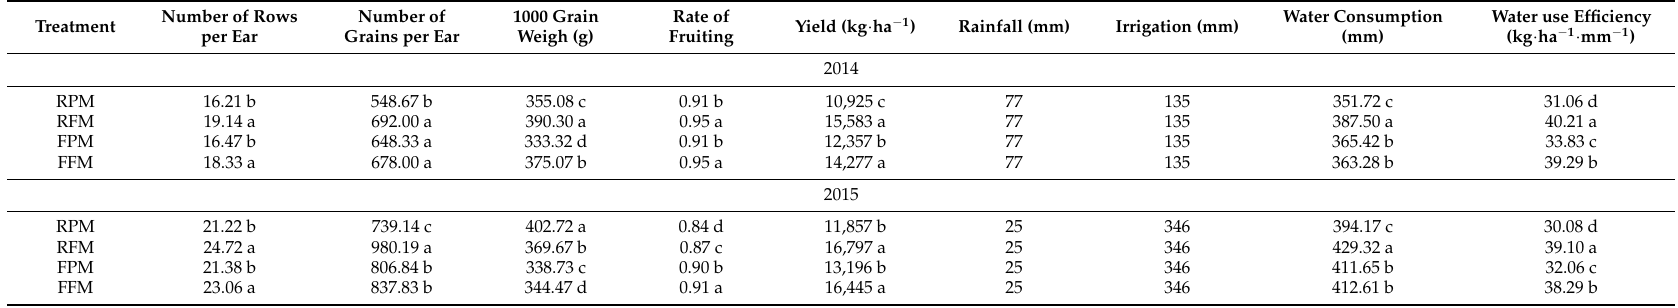
Table 4. Effect of treatments on the yield, its component factors, and water use efficiency (WUE) in 2014 and 2015.